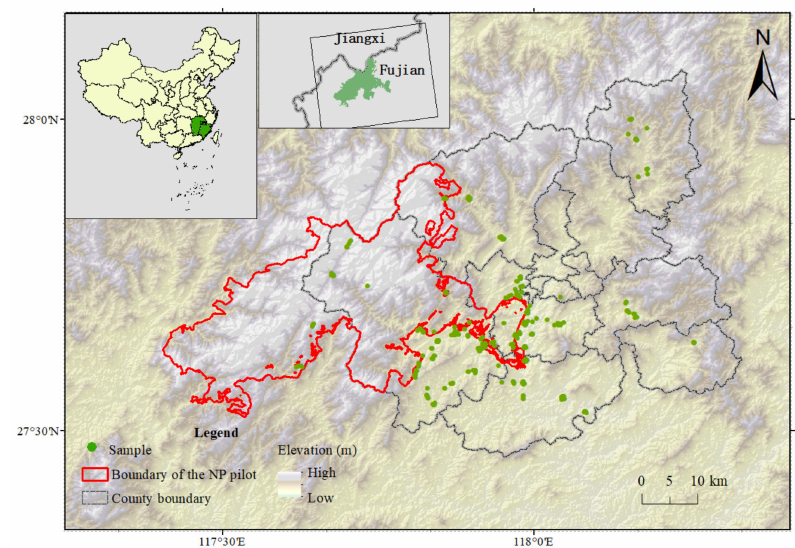
Figure 1. The map of the city of Wuyishan and the location of the National Park